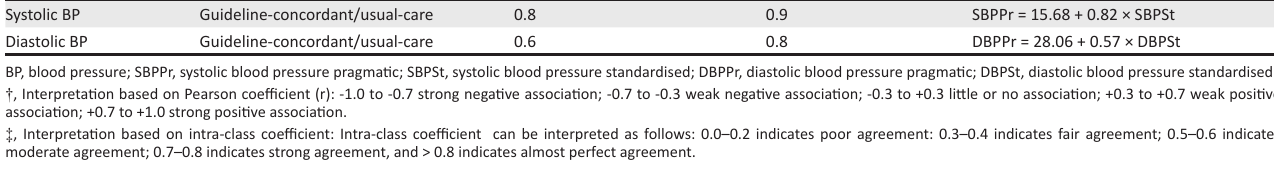
TABLE 5: Pearson ( r ), intra-class coefficient and regression equations for blood pressure measurement methods. Blood pressure BP measurement method in